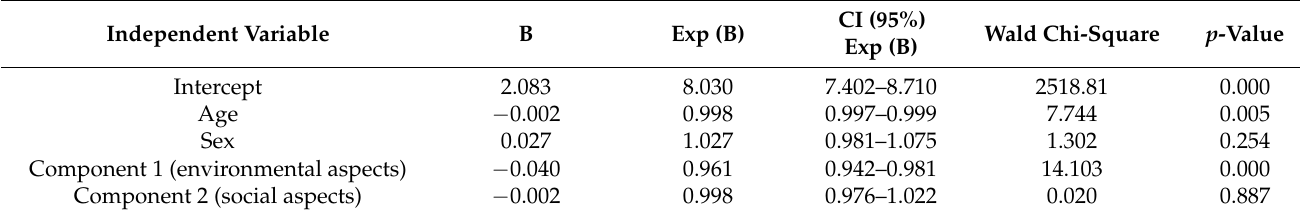
Table 3. Poisson regression model used to estimate the time frame between the onset of COVID-19 symptoms and the entry into the health care system ( n =